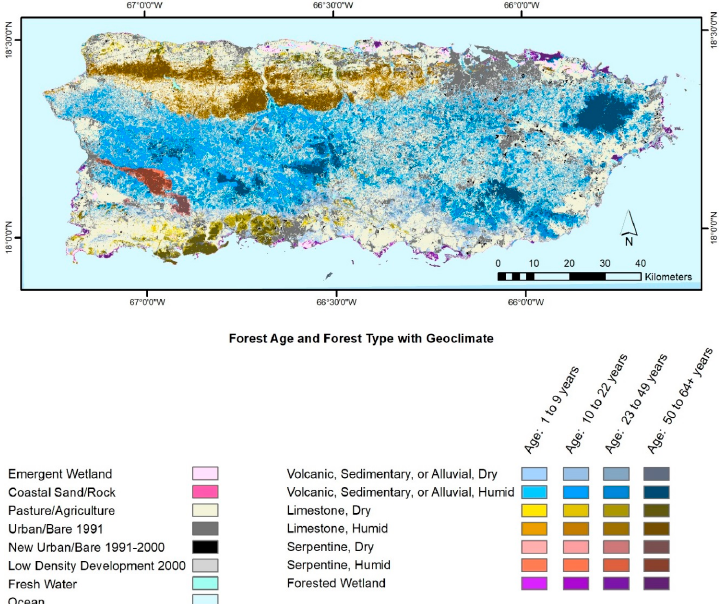
Figure 2. Puerto Rico dry vs. humid geoclimatic zones by forest age [43] . The oldest humid forests on volcanic substrates are at high elevations.